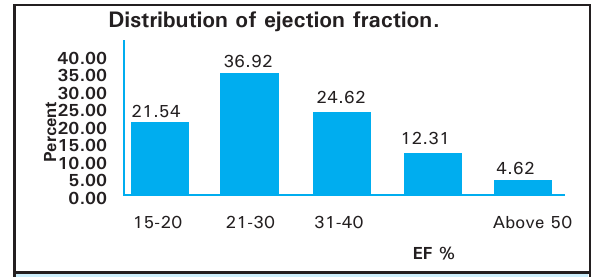
Figure 2. Distribution of ejection fraction.